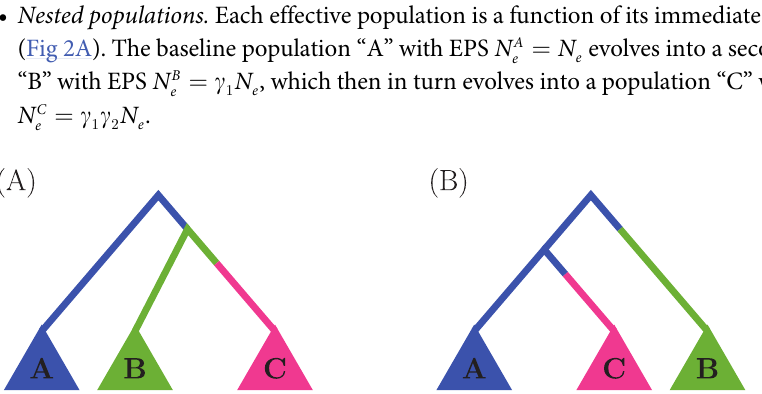
Fig 2. Modeling of multiple subpopulations with dependent population size dynamics. The trees represent large genealogies of many sequences from three different subpopulations labeled “A”, “B” and “C” at the tips of the trees. Each lineage represents the subtrees of individuals whose rate of coalescence is dictated by the color of the branch. (A) Nested populations. The blue branch indicates coalescent events happen at rate that depends on N A ¼ N , green e e branch indicates a coalescent rate that depends on N B ¼ g , and pink branch indicates a coalescent rate that 1 N e e depends on N C ¼ g g . (B) Radial populations. The blue branch indicates a coalescent rate that depends on 1 2 N e e ¼ N , the green branch indicates a coalescent rate that depends on N B ¼ g , and pink branch indicates a N A 1 N e e e e coalescent rate that depends on N C ¼ g . 2 N e e